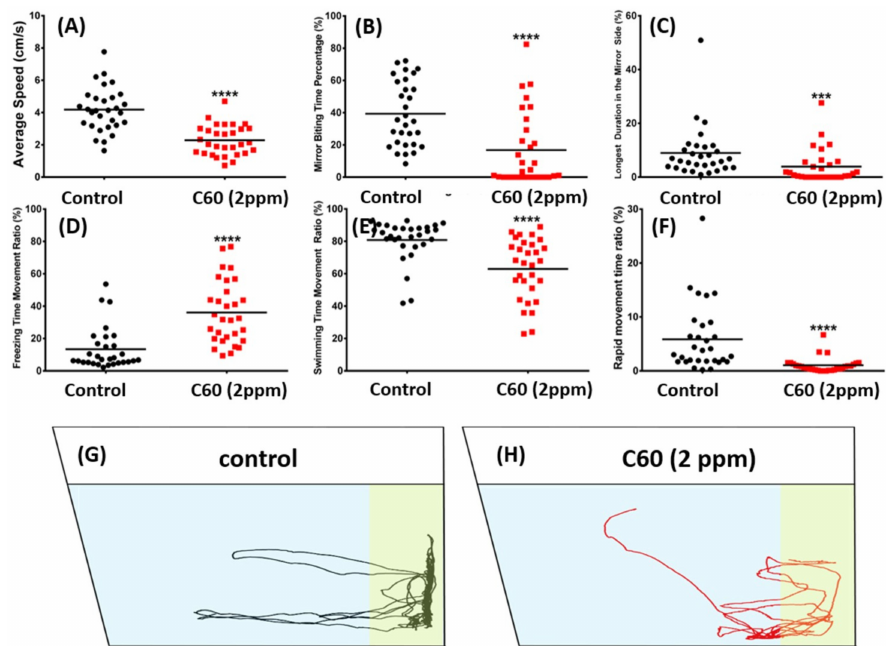
Figure 5. Comparison of mirror biting behavior endpoints between wild-type and C 60 NPs-exposed zebrafish after seven-day exposure. ( A ) Average speed, ( B ) mirror biting time percentage, ( C ) longest duration in the mirror side, ( D ) freezing time movement ratio, ( E ) swimming time movement ratio, and ( F ) rapid movement time ratio were analyzed. The swimming trajectories of control (black color in ( G )) and C 60 NPs-exposed fish (red color in ( H )) for mirror biting test were recorded and compared. The data are expressed as the means and were analyzed by Mann–Whitney test ( n = 30 for control; n = 30 for C 60 NPs-exposed fish; *** p < 0.001, **** p <